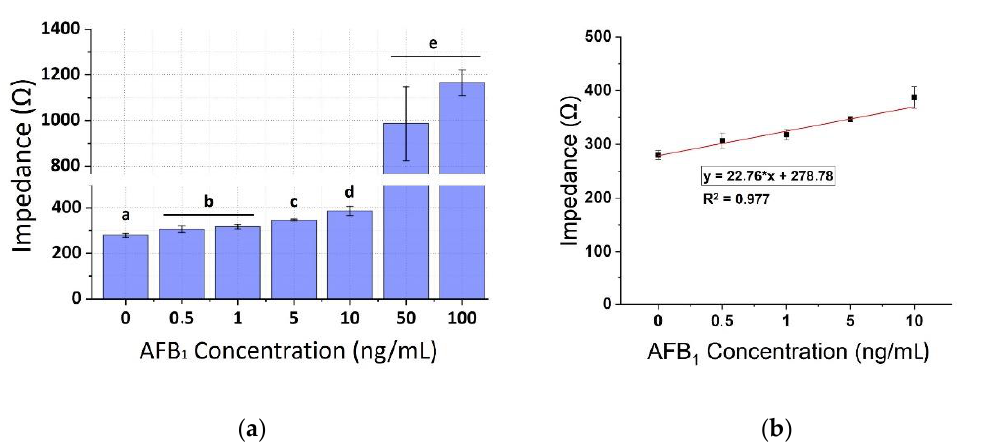
Figure 6. ( a ) Extracted results from the mean impedance magnitude values for di ff erent concentrations of AFB 1 standard solutions tested at three frequencies 1 KHz ± STD, Di ff erent letters (a, b, c, d, e) indicate statistically significant di ff erent values ( p < 0.05), ( b ) Linear fit curve of the values of the mean impedance magnitude for concentrations of AFB 1 standard (0–10 ng / mL) tested at 1 KHz.